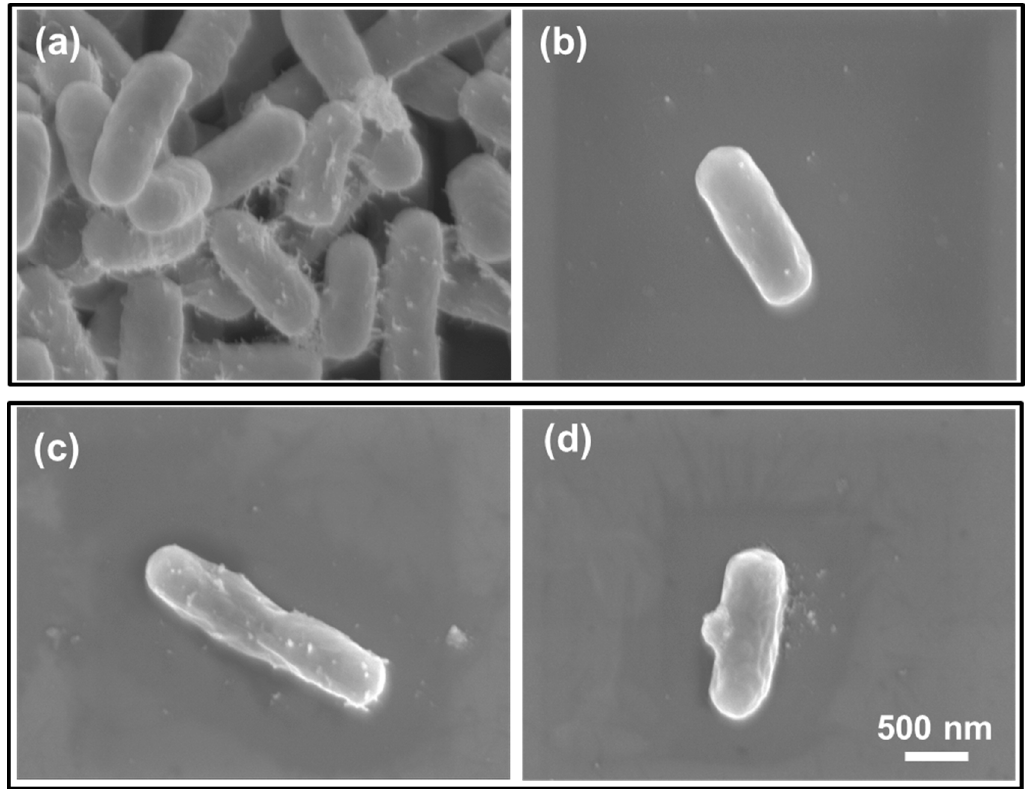
Figure 8. S10 CAPJ disrupts bacterial cell wall integrity. The FE-SEM images of the bacterial morphologies before CAPJ treatment ( a , b ) and after S10 CAPJ treatment ( c , d ).